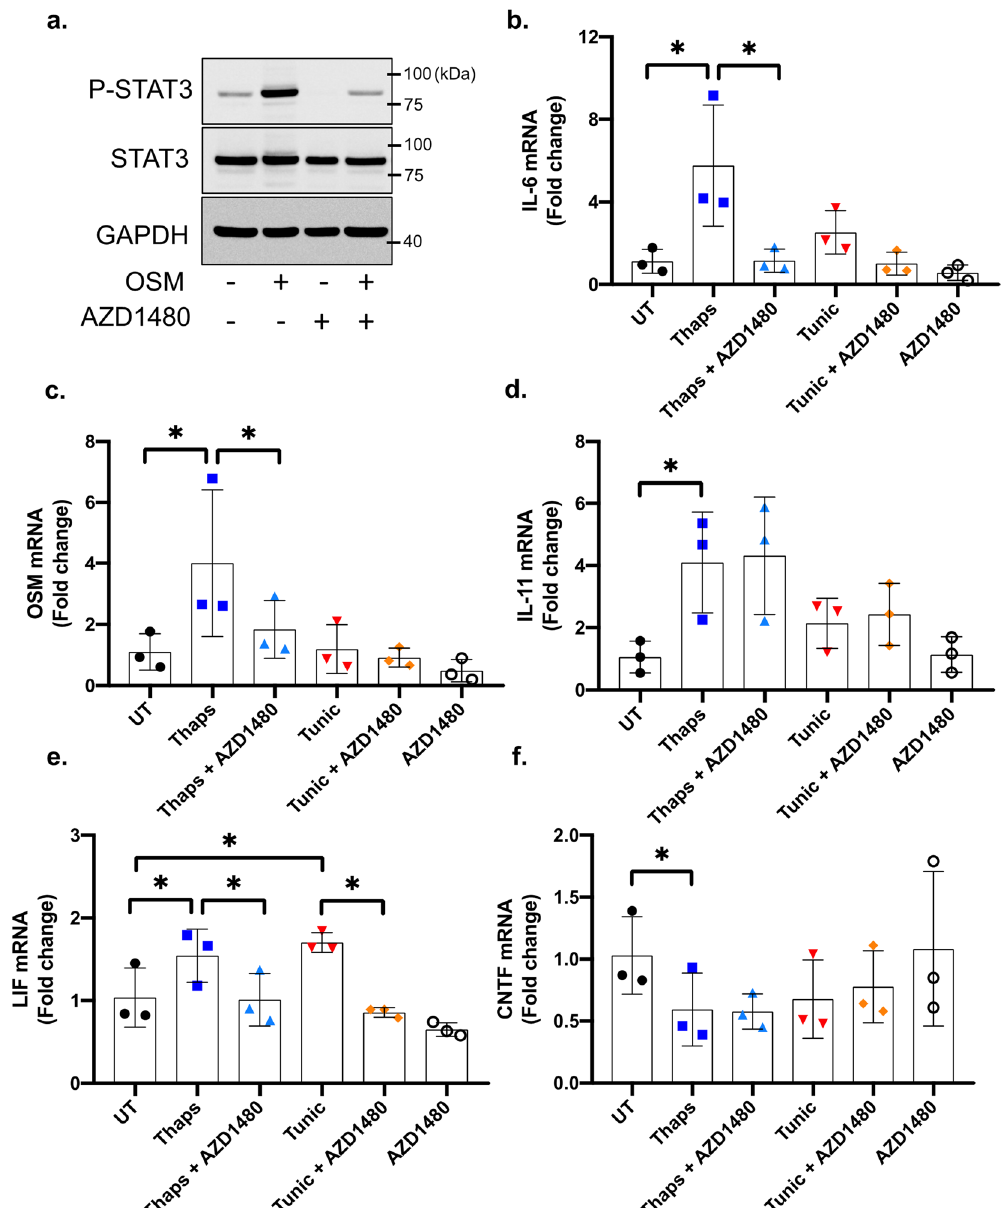
Figure 7. JAK-dependent regulation of the IL-6 cytokine family in murine astrocytes. ( a ) Primary murine astrocytes were pre-treated for 30 min with the JAK1/2 inhibitor, AZD1480 (2 µ M) followed by stimulation with 2.5 ng/ml of OSM. Cell lysates were then immunoblotted. ( a – f ) Cells were pretreated with AZD1480 for 30 min before stimulation with 1 μ M thaps and 5 μ M tunic for 4 hours. mRNA expression was analyzed by qPCR. * p ≤ 0.05, N = 3. Full-length blots are presented in Supplementary Fig.